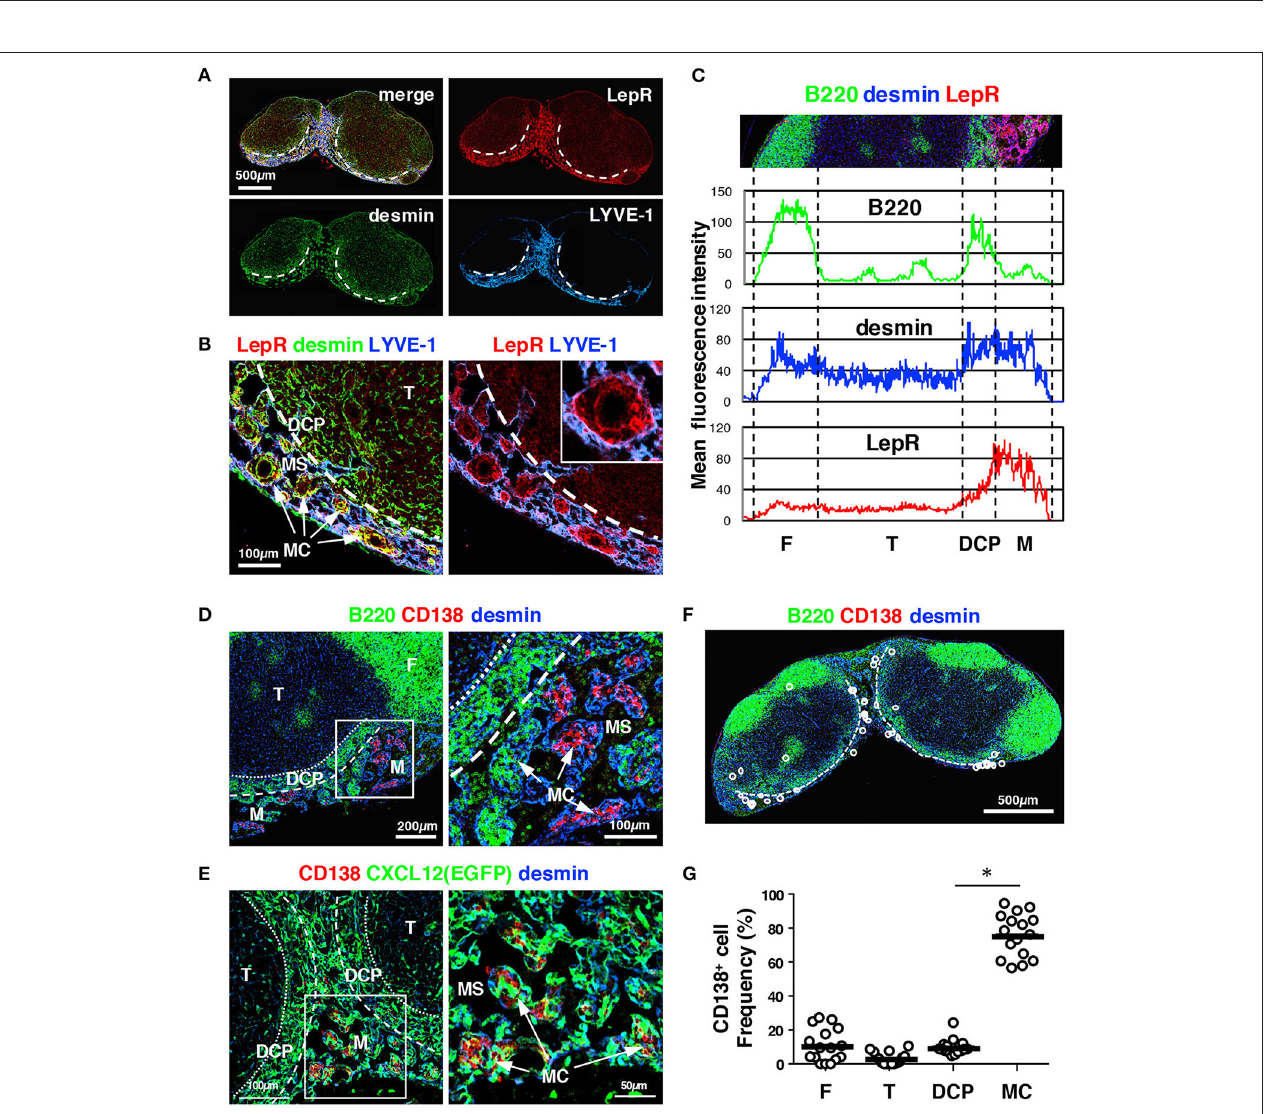
FIGURE 8 | The MC in the mouse LN is a unique structure comprising MCRCs. (A) LepR is highly expressed in the medulla. A section of a brachial LN from a wild type B6 mouse was stained with the indicated markers. The dotted lines indicate the boundary between the DCP and medulla. (B) FSCs in the MC showed the highest expression of LepR. The inset shows a higher magnification view of a MC. (C) Average fluorescent intensity profiles of B220, desmin, and LepR along the cortex–medulla axis. Note that LepR expression is prominent in the medulla, and shows a similar pattern to LYVE-1 in Figure 3D , indicating preferential expression in the medulla. (D) Plasma cells preferentially accumulate in the MCs. Shown is a wild type B6 mouse LN. (E) Plasma cells make close contacts with MCRCs. Shown is a Cxcl12 -EGFP mouse LN. (F,G) Quantitative analysis of plasma cell localization in LN subcompartments (bars: mean; asterisks: significantly different compared to the follicles, p < 0.0001). (F) A representative image of plasma cells. The dotted lines indicate the boundary between the DCP and medulla. (G) Proportions of plasma cells in each subcompartment compared to the total number in the LN were plotted (open circles; bars: mean; * p < 0.0001).